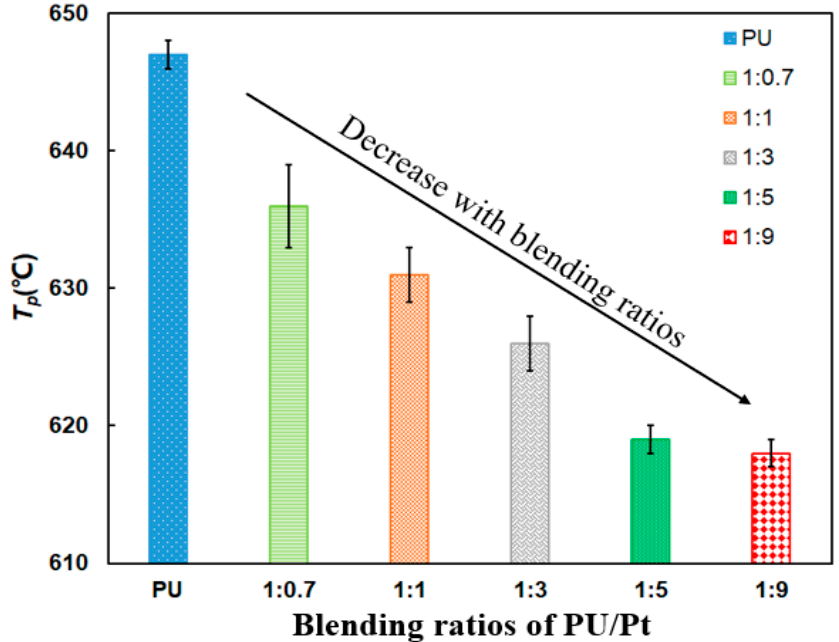
Figure 9. Comparison of T p of PU/Pt mixtures at different blending ratios.